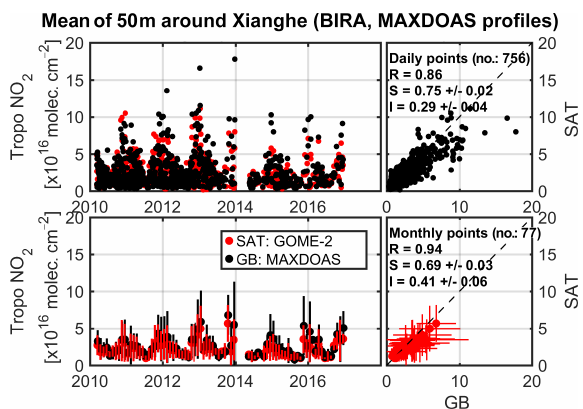
Figure 20. Daily and monthly mean time series and scatter plot of GOME-2 (upper row) and MAXDOAS tropospheric NO 2 columns (mean value of all the pixels within 50km of Xianghe).